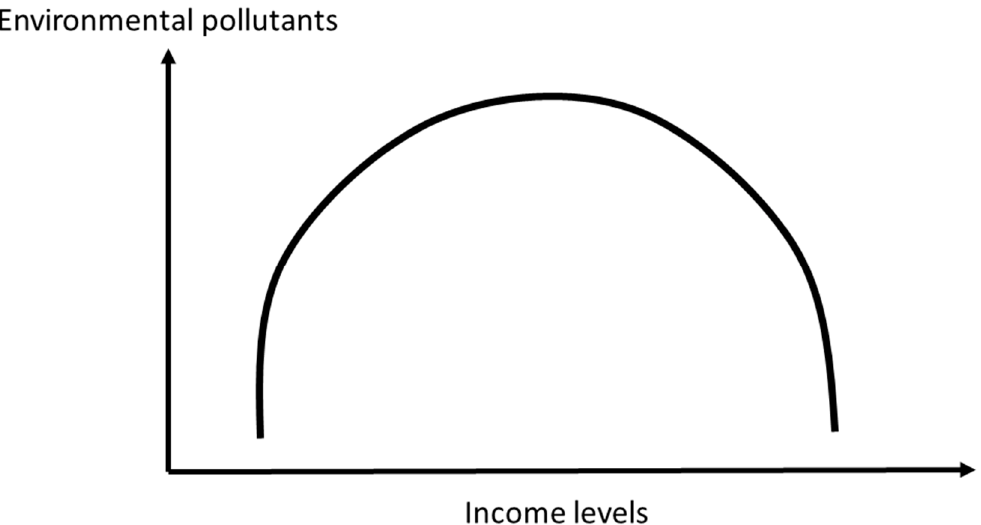
Figure 1. Stylised example of the Environmental Kuznets Curve.